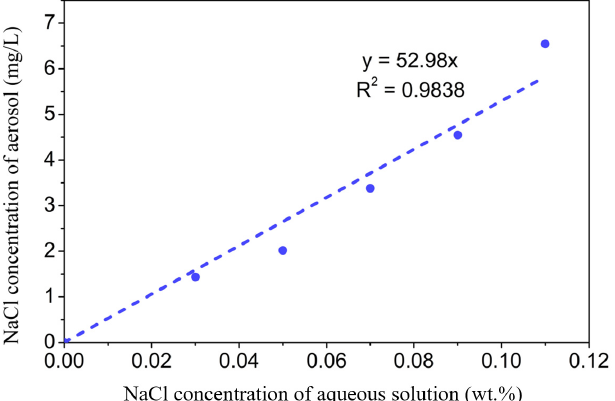
Figure 7. Measured NaCl concentration of the aerosol as a function of salt concentration of the aqueous solution.